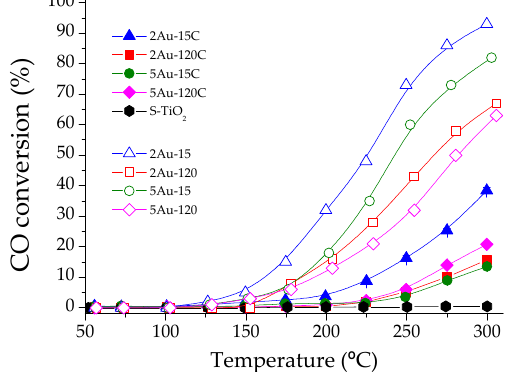
Figure 6. Catalytic activity of the prepared catalysts during the CO oxidation.